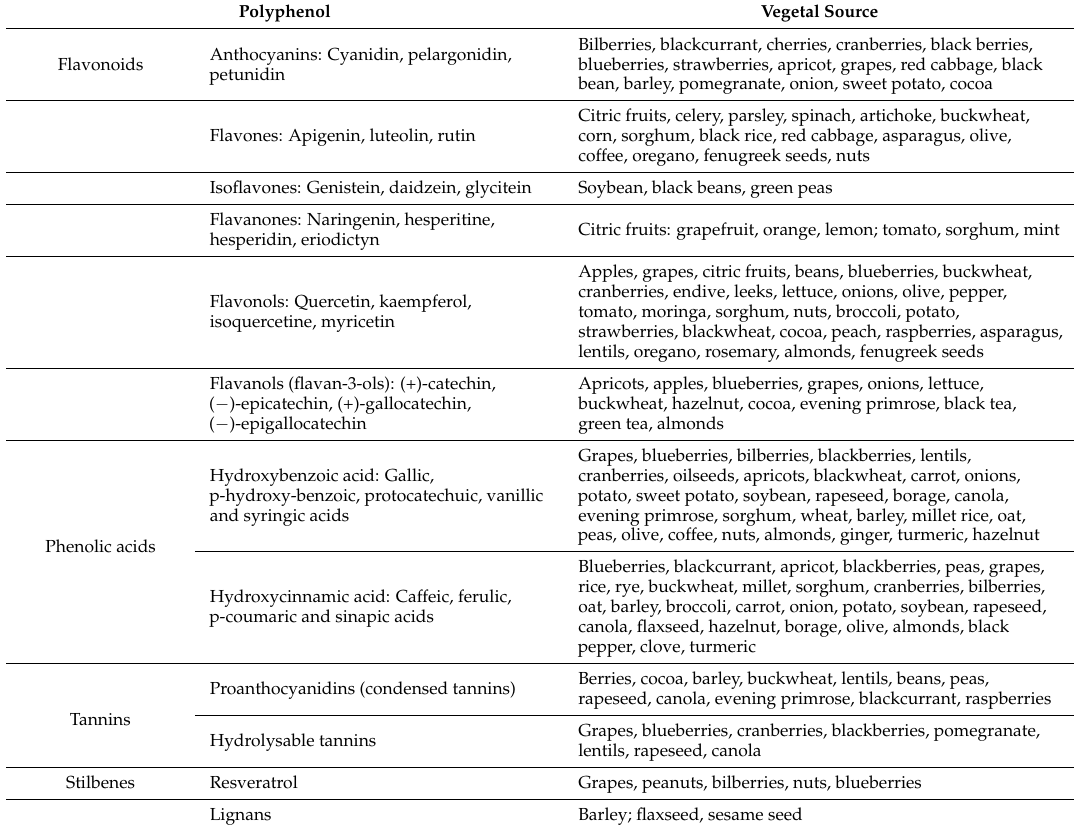
Table 2. Main phenolic compounds in some vegetal sources